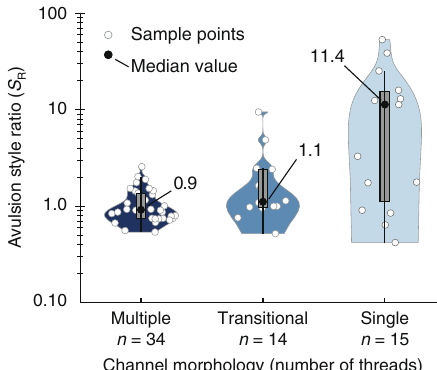
Fig. 4 Avulsion style is related to channel morphology. Rivers with multiple fl ow threads have the smallest median S R values. Avulsions in transitional channels, or those with alternating reaches of multiple threads and single threads, also have a small median S R , but they have a larger range than events in channels with multiple threads. Avulsions on single- thread channels have the highest median S R . Numbers refer to median values of the distributions, boxes show the 2nd to 3rd quartile ranges, and lines extending from boxes represent the 1st to 2nd and 3rd to 4th quartile